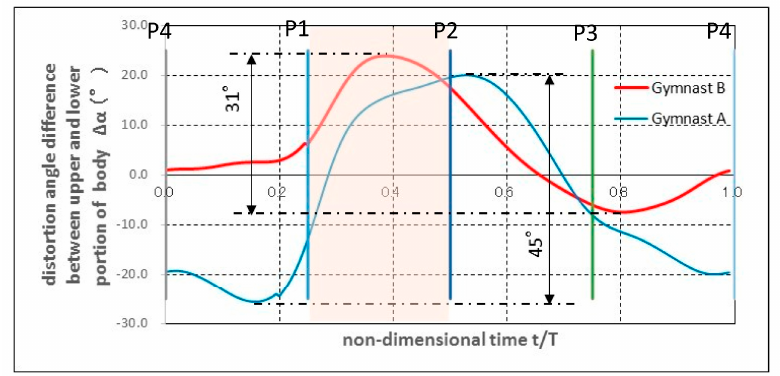
Figure 4. Distortion angle between the upper and lower